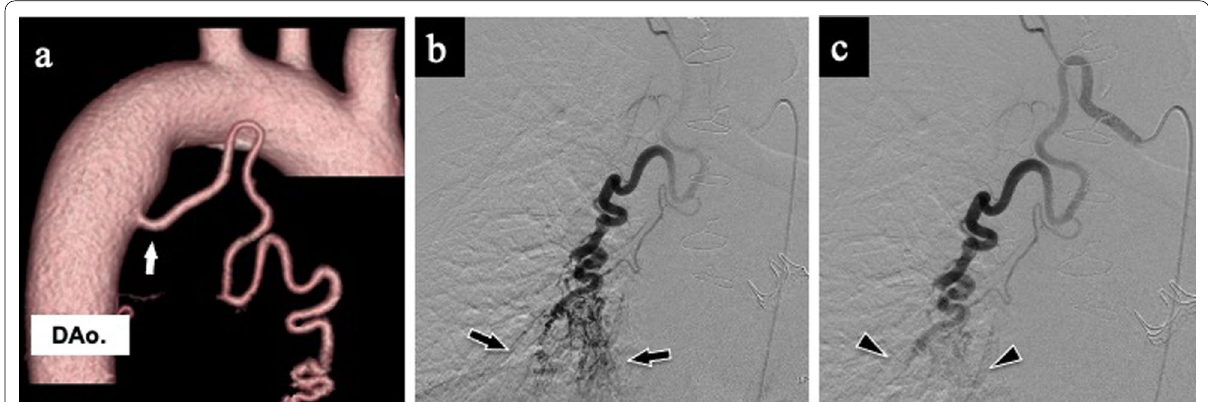
Fig. 2 Preoperative computed tomography and angiography images in case 2: a BAH identified on preoperative three-dimensional CT image (white arrow); b pulmonary parenchymal blush in the right lower lobe demonstrated on BA angiography (arrows); c disappearance of parenchymal blush after embolization using a liquid embolic agent (arrowheads). BAH bronchial artery hypertrophy, CT computed tomography, BA bronchial artery, DAo descending